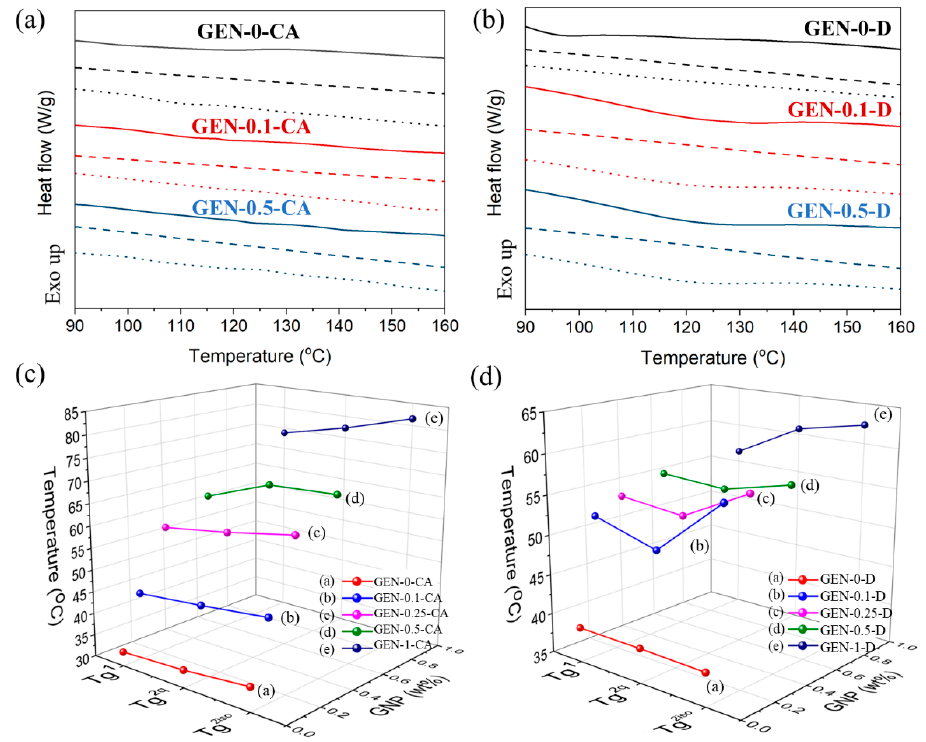
Figure 6. DSC thermogram of the control A epoxy resin (CA) and Diels-Alder epoxy resin (D systems). ( a ) and ( b ) present the heat flows of the composites (solid line: first scan, dashed line: second scan after the quenching process, dotted line: second scan after isothermal processing at 70 ◦ C for 1 day). ( c ) and ( d ) display the changes in T g based on the measurement method and GNP content ( T g1 : T g for the first scan, T g2q : T g for the second scan after the quenching process, T g2iso : T g for the second scan after the isothermal process).